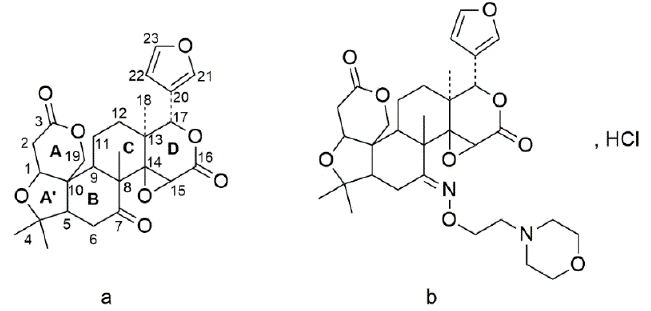
Figure 1. The chemical structures of limonin ( a ) and HY-071085 ( b